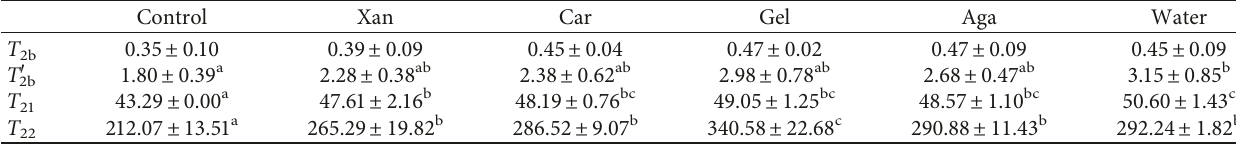
Table 4: Effects of different hydrocolloids in intramuscular injection on T 2 relaxation times of water molecules in porcine meat. Control Xan Car Gel Aga Water